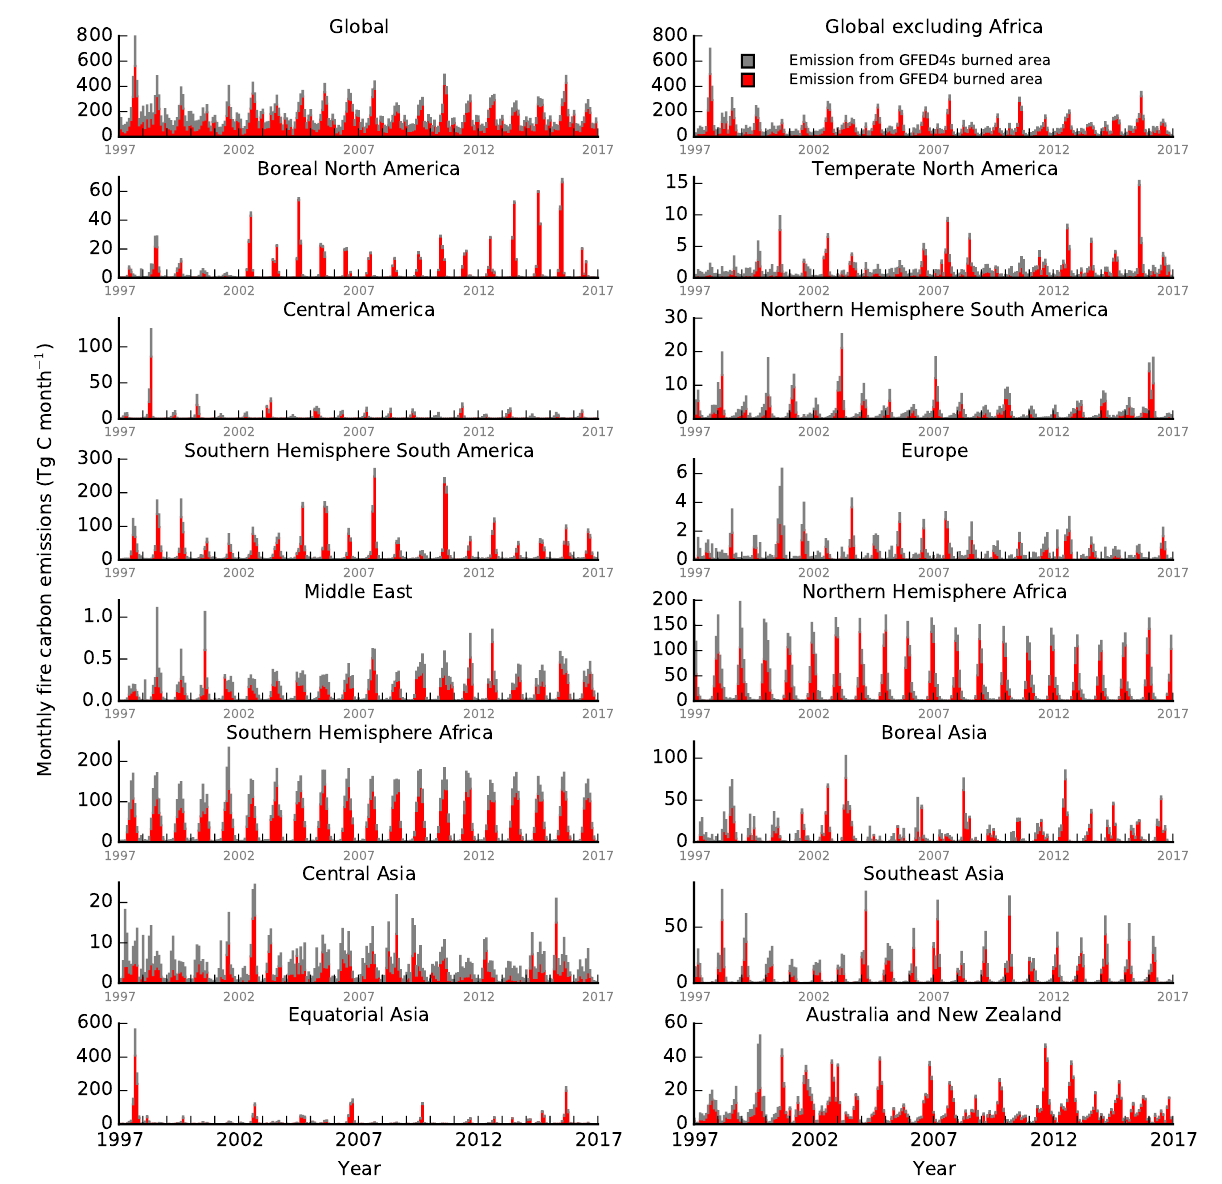
Figure 10. Monthly emissions from GFED4 (red) and GFED4s